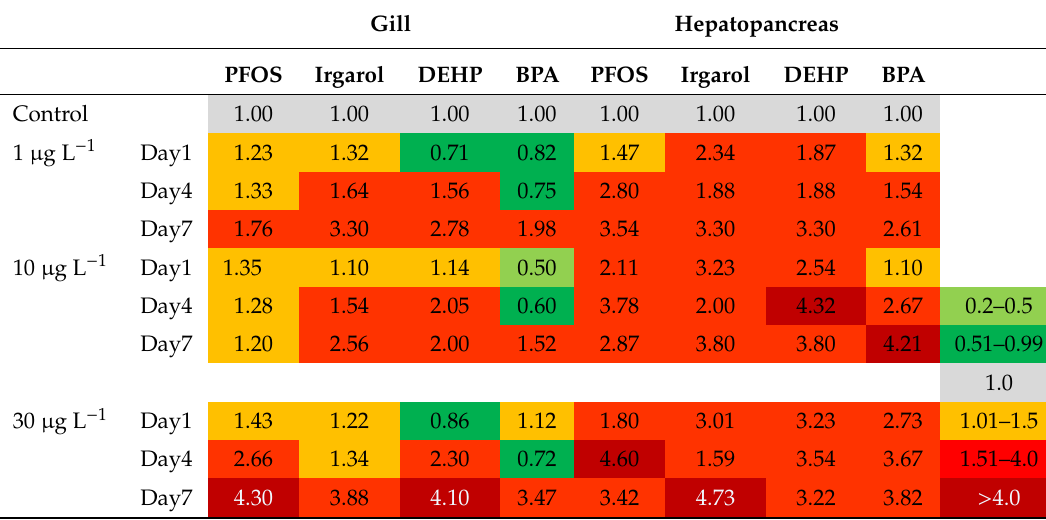
Table 1. Summary of relative expression level of p38 MAPK in gills and hepatopancreas of M. japonicus that had been exposed to di ff erent doses of 1, 10, and 30 µ g L − 1 PFOS, irgarol, di(2-ethylhexyl) phthalate (DEHP), bisphenol A (BPA), and solvent control at di ff erent time points (days 1, 4, and 7) by a color schematic representation (green color: low expression level of p38 MAPK compared with the control, red color: high expression level of p38 MAPK compared with the control). Each transcript was determined using GAPDH by the 2 − ∆∆ Ct method. Relative fold-change in gene expression was determined by dividing the average relative expression of each individual at each time point by the average relative expression of solvent control individuals at day 1 ( n = 120). Relative fold change mRNA expression for p38 MAPK gene for control at day 1 = 1. Gill